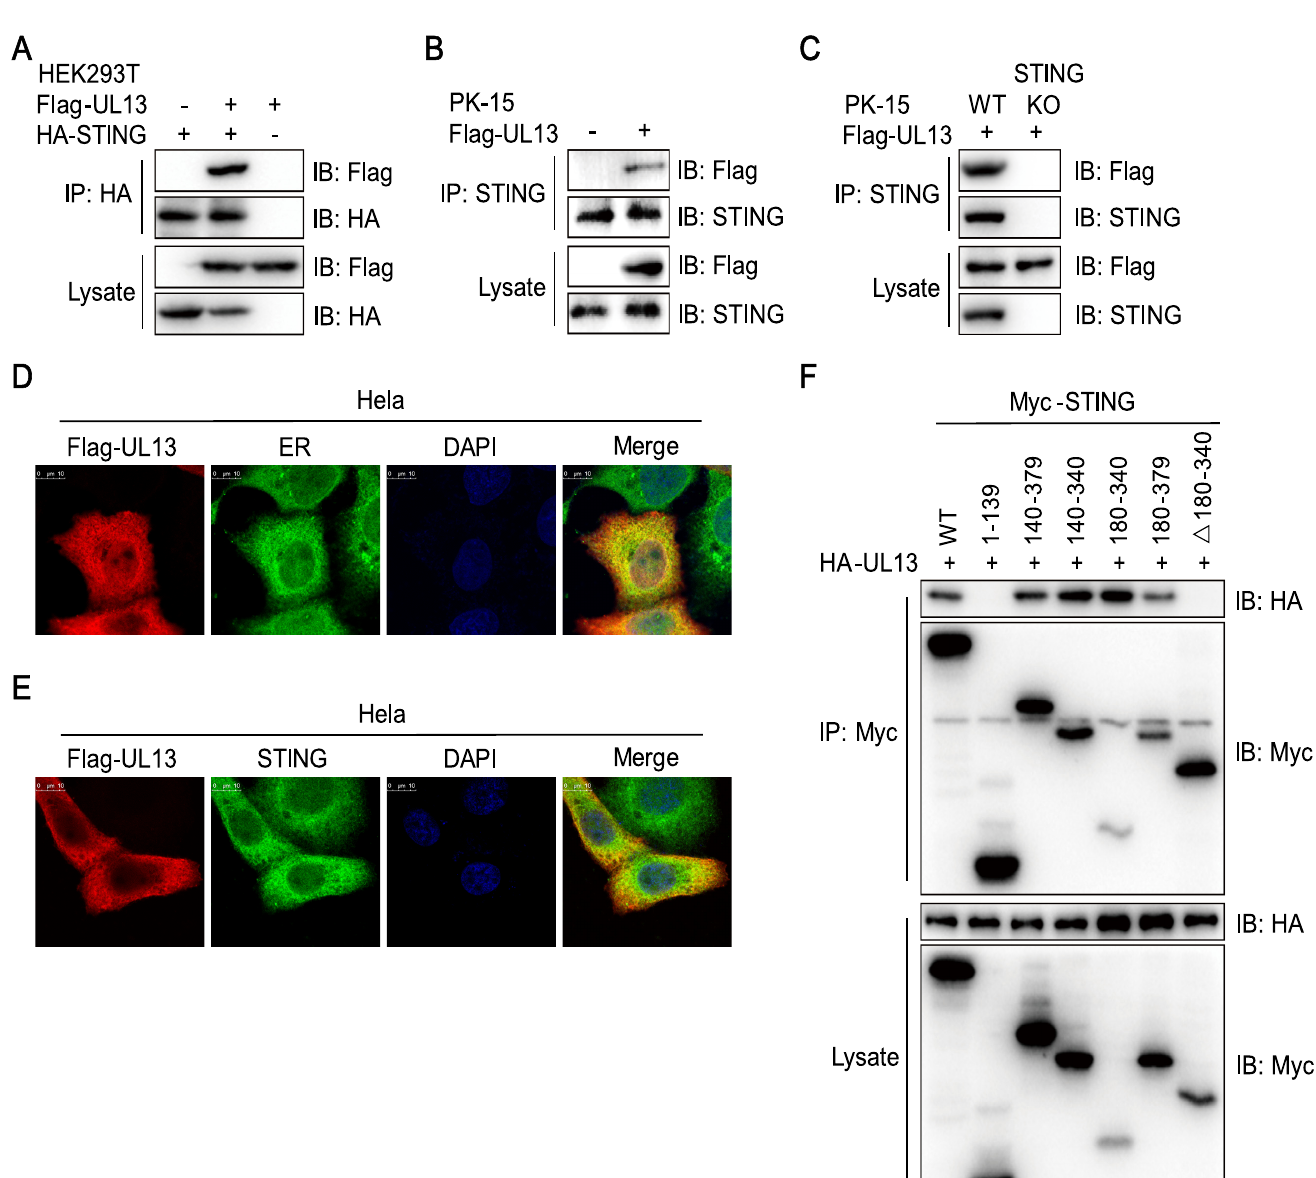
Fig 3. UL13 associates with STING. (A-C) Immunoblotting (IB) analysis of indicated proteins in immunoprecipitated (IP) samples and whole-cell lysates of HEK293T cells transfected with Flag-UL13 and HA-STING (A), whole-cell lysates of PK-15 cells transfected with Flag-UL13 (B), or STING-deficient PK-15 cells transfected with Flag-UL13 (C). Anti-HA (A) or anti-STING (B, C) immunoprecipitates were analyzed by immunoblotting with anti-Flag antibodies. Levels of the transfected proteins were analyzed by immunoblotting with anti-HA (A), anti-STING (B, C), or anti-Flag (A-C) antibodies. (D) Colocalization of UL13 and STING. Hela cells were transfected with Flag-UL13 as indicated for 24 h before confocal microscopy. Endogenous STING was labeled by anti-STING antibody. (E) Colocalization of UL13 and endoplasmic reticulum (ER). Hela cells were transfected with Flag-UL13 for 24 h before confocal microscopy. ER was labeled with anti- Calreticulin antibody. (F) Immunoblotting analysis of UL13 and STING in immunoprecipitated samples or whole-cell lysates of HEK293T cells transfected with HA-UL13 and full length or truncated Myc-STING. Anti-Myc immunoprecipitates were analyzed by immunoblotting with an anti-HA or anti-Myc antibody. Levels of the transfected proteins were analyzed by immunoblotting with an anti-HA or anti-Myc antibody. Scale bars, 10 μ m. Data are representative of two independent experiments (A-F).